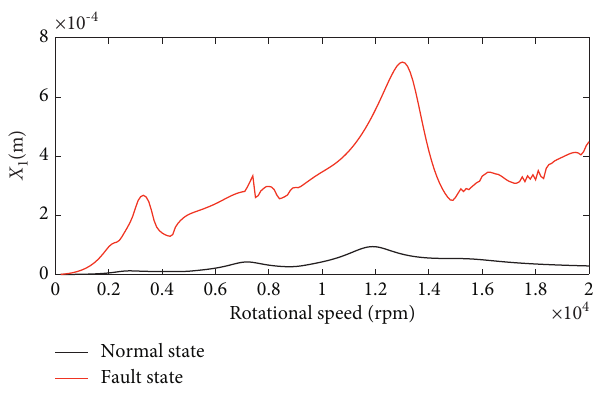
Figure 10: Vibration response